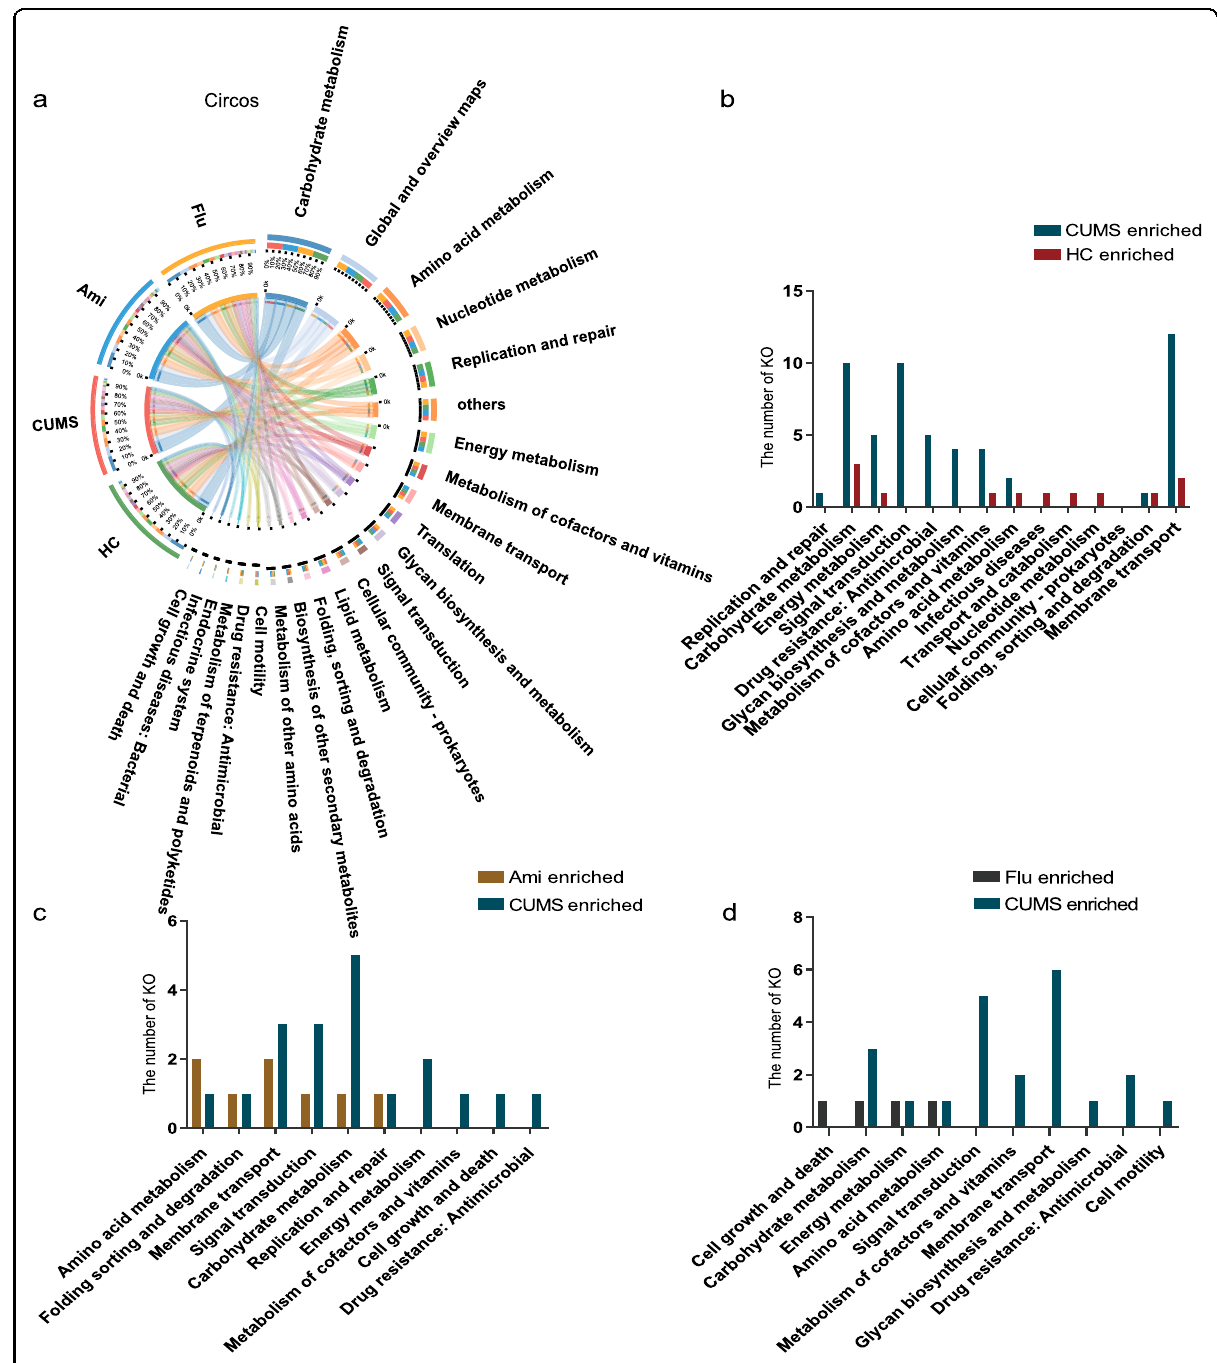
Fig. 6 KEGG metabolic pathway analysis via metagenomics sequencing. a Distribution of KEGG metabolic pathways at level 2. b Comparison between the HC-enriched and CUMS-enriched KOs on level 2 of KEGG functional category. c Comparison between the CUMS-enriched and Ami- enriched KOs on level 2 of the KEGG functional category. d Comparison between the CUMS-enriched and Flu-enriched KOs on level 2 of the KEGG functional category. The abundance of KO in one group is signi fi cantly higher than that of other groups, indicating